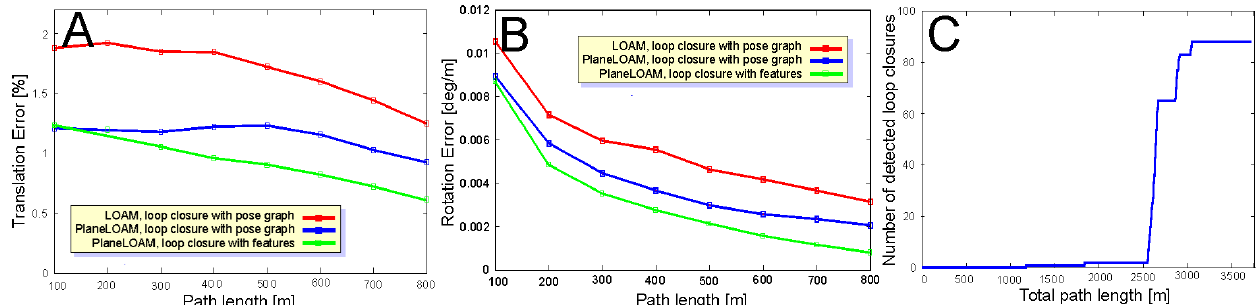
Figure 22. Influence of the loop closing method on the trajectory estimation accuracy for the KITTI 00 sequence shown according to the standard KITTI evaluation method [48] as the separate translation ( A ) and rotation ( B ) error. The number of detected loop closure proposals increases significantly while the vehicle progresses along the path and re-visits the already mapped areas ( C